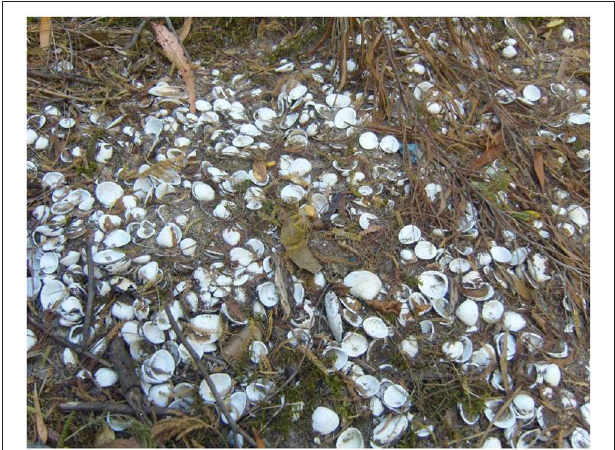
FIGURE 3 | Accumulation of C. fluminea after the 2001 flood in the banks of Minho River. This photo was taken in 2014, 13 years after the flooding, showing the longer-term impacts that additions of shells can have on an